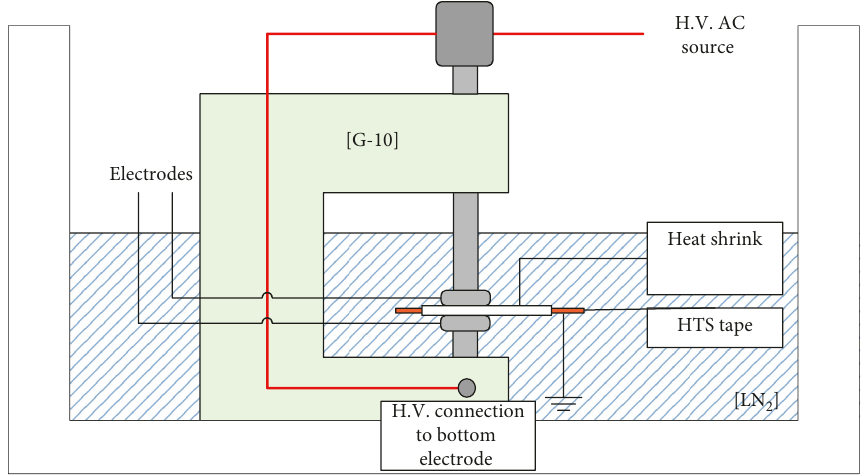
Figure 4: A schematic of the experimental setup used for breakdown voltage measurements on insulated tape in LN